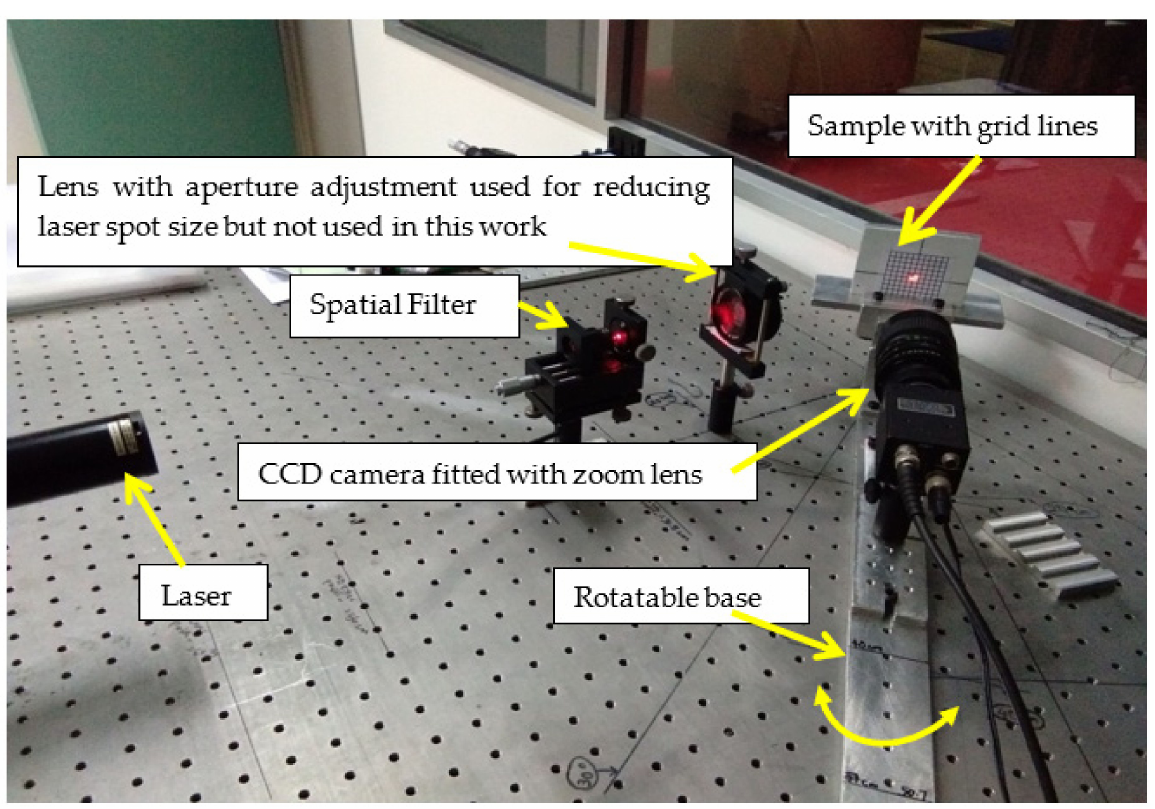
Figure 2. Experimental setup 1.